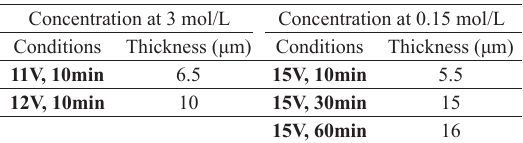
Table 3. Thicknesses of the anodized samples with a thermal treatment of 750ºC obtained with profilometry. Concentration at 3 mol/L